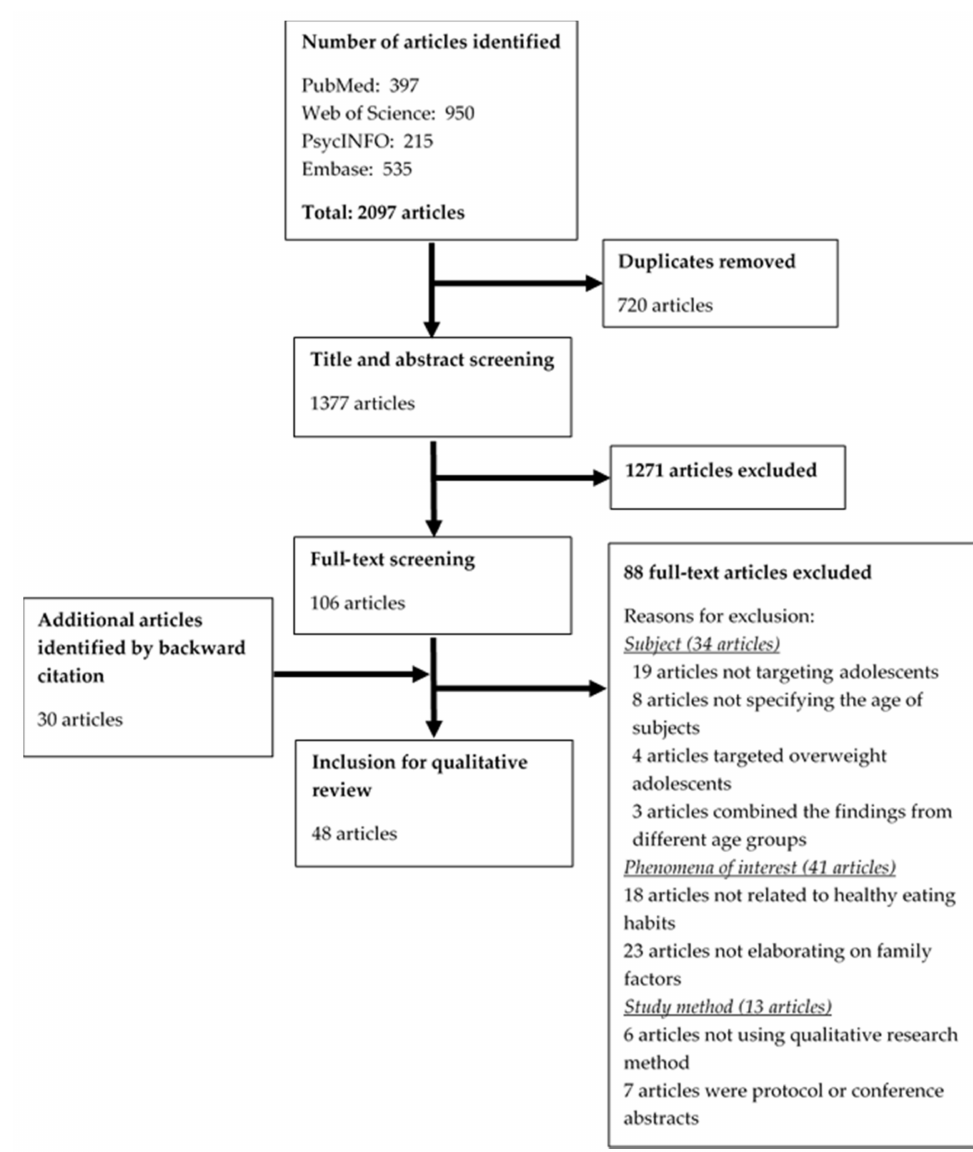
Figure 2. PRISMA flow diagram on study